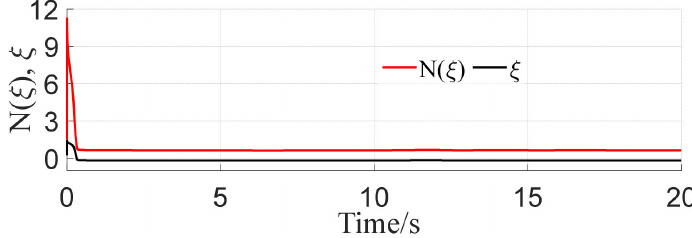
Figure 6. The outputs of N ( ξ ) and ξ